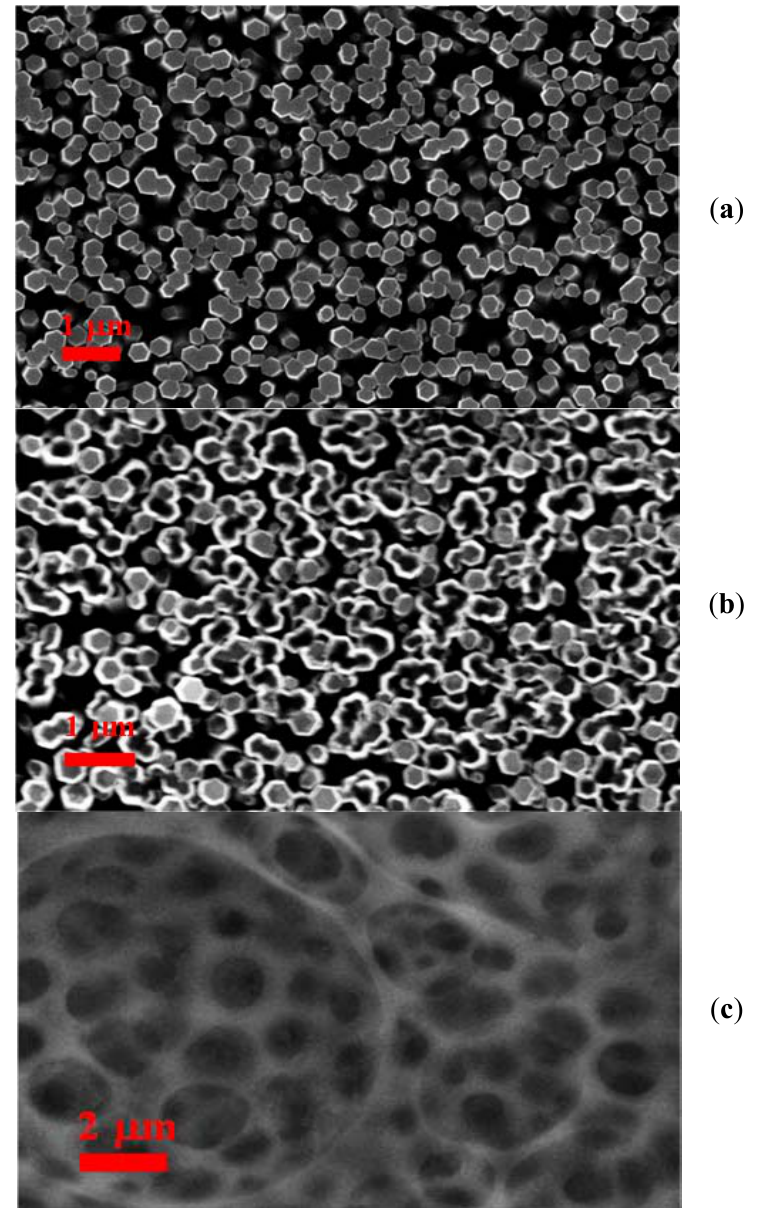
Figure 1. ( a ) FESEM image of ZnO nanorods grown on a gold coated glass substrate, ( b ) FESEM image of ZnO nanotubes after chemical etching, and ( c ) FESEM image of the functionalized ZnO